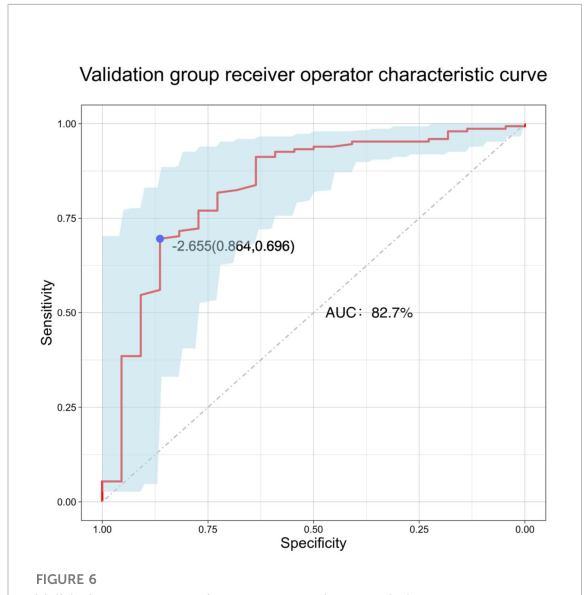
FIGURE 6 Validation group receiver operator characteristic